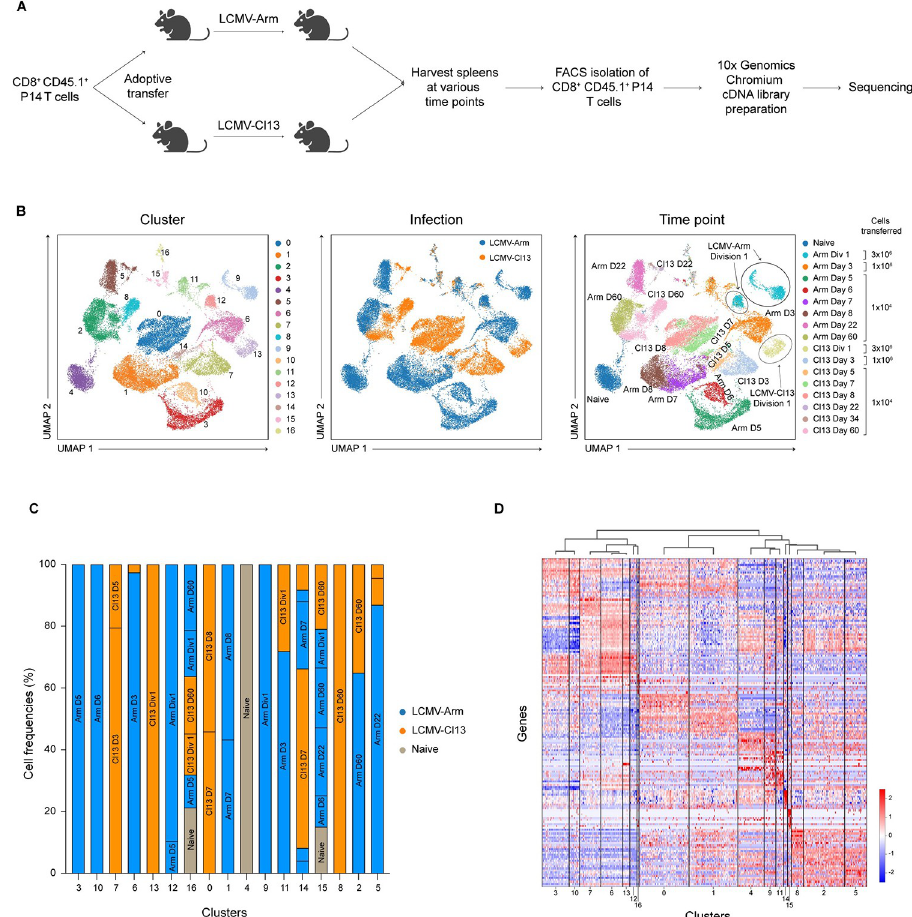
Fig 1. scRNA-seq analyses of CD8 + T cells responding to acute vs. chronic infection. ( A ) Experimental setup. CD8 + CD45.1 + P14 T cells were adoptively transferred into separate CD45.2 + hosts 1 day prior to infection with either LCMV-Arm or LCMV-Cl13. To identify cells that had undergone their first division, some cells were labeled with CFSE prior to adoptive transfer. Splenocytes were harvested at the indicated time points after infection. Donor P14 CD8 + T cells were FACS-isolated and processed for scRNA-seq using the 10x Genomics Chromium platform. ( B ) UMAP clustering of all CD8 + cells, colored by cluster identity (left), infection type (middle), or time point (right); the three Division 1 clusters are circled for emphasis. ( C ) Bar graphs indicating the infection type and time point from which cells derived from each cluster are derived; clusters are grouped according to similarity in gene expression based on (D). ( D ) Hierarchical clustering of clusters based on gene expression profiles. The raw data for the panels in this figure are located in S1 Data file. Fig 1A created with BioRender.com. CFSE, carboxyfluorescein succinimidyl ester; LCMV-Arm, LCMV-Armstrong; LCMV-Cl13, LCMV-Clone 13; scRNA-seq, single-cell RNA-sequencing; UMAP, Uniform Manifold Approximation and